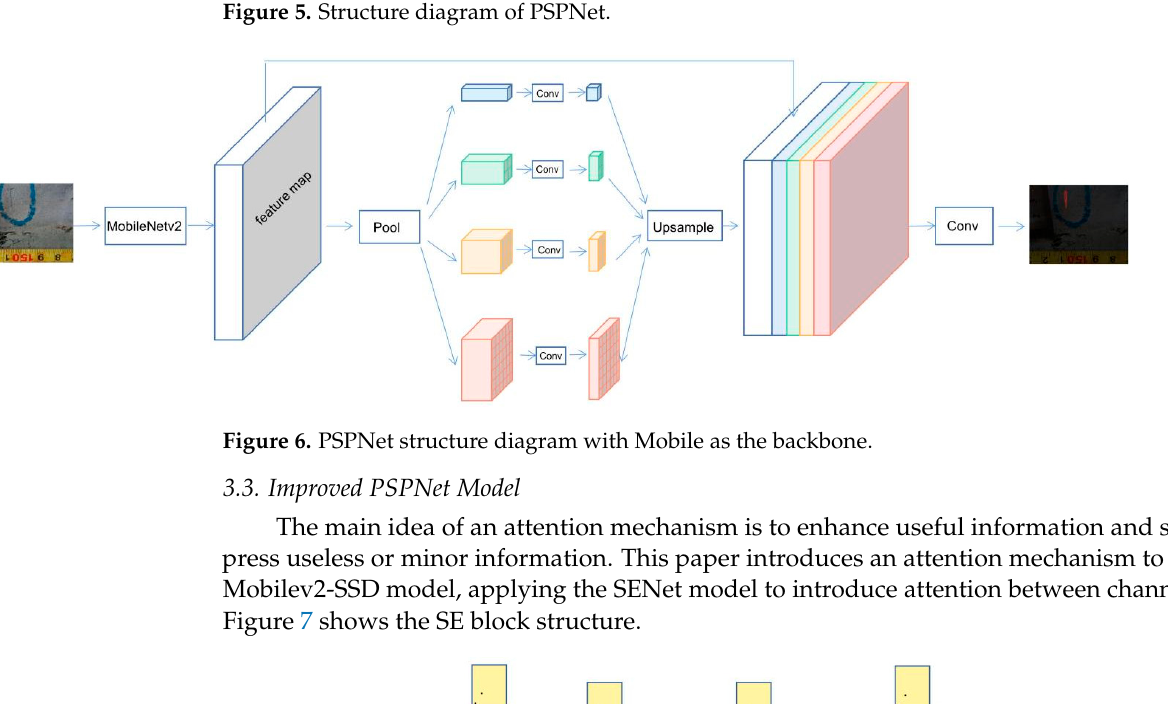
Figure 8. PSPNet architecture diagram with MobileNetv2 as backbone.